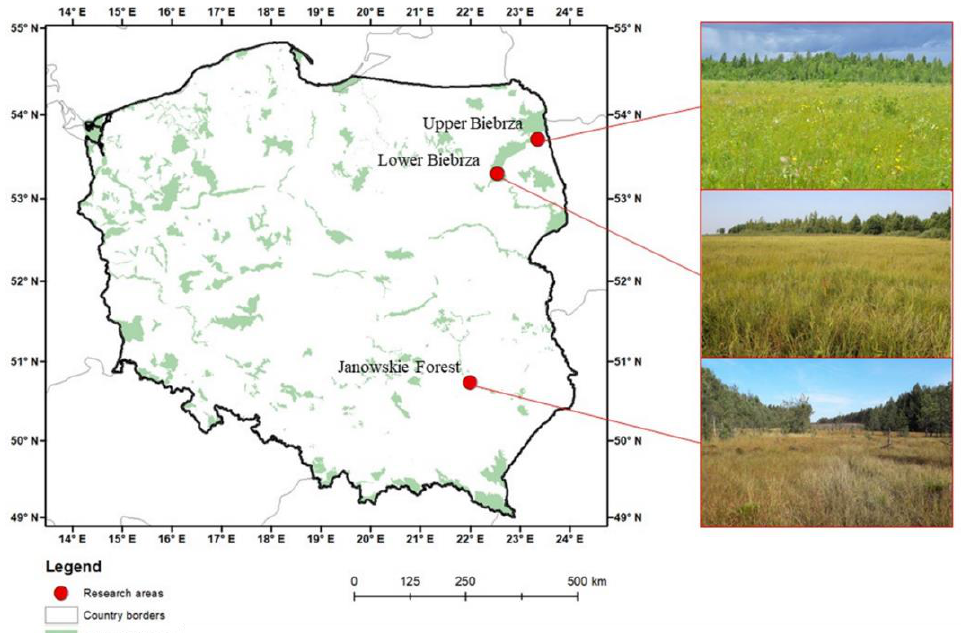
Figure 1. Location of alkaline fens and transition mires and quaking bogs (habitat codes: 7230 and 7140, respectively, the Council Directive 92/43/EEC, [8]), the Natura 2000 research areas in the Biebrza River Valley (Upper Biebrza—UB; Lower Biebrza—LB), and the Janowskie Forest (JF).